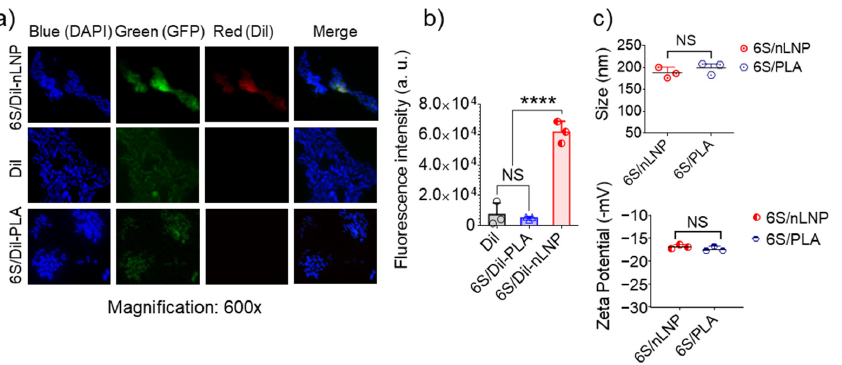
Figure 1. E. coli uptake of reassembled lipid NPs. E. coli (ATCC-25922-GFP; green) were cultured in the presence of Dil-labeled 6S/nLNPs (1 μ g/mL), free Dil (1 μ g/mL), or Dil-labeled 6S/PLA NPs (1 μ g/mL) for 4 h, washed with PBS and fixed in 4% PFA, followed by staining of nuclei with DAPI (blue). Images were acquired using an Olympus BX63 fluorescence microscope with a 60× objective. Data are representative of three experiments. ( a ) Representative microscopic images of E. coli treated with Dil-labeled 6S/nLNPs (6S/Dil-nLNP), free Dil, or Dil-labeled 6S/PLA NPs (6S/Dil-PLA). ( b ) Comparison of red fluorescence intensity quantified using ImageJ ( n = 3; **** p < 0.0001, NS: non- significant). ( c ) Comparison of size and zeta potential of 6S/nLNPs and 6S/PLA NPs ( n = 3, NS: non- significant).